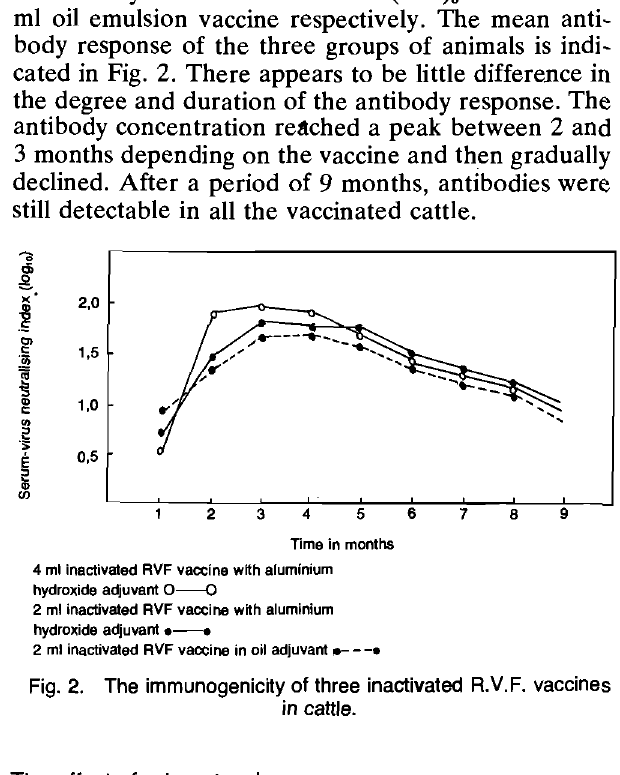
Fig. 2. The immunogenicity of three inactivated R.V.F. vaccines in